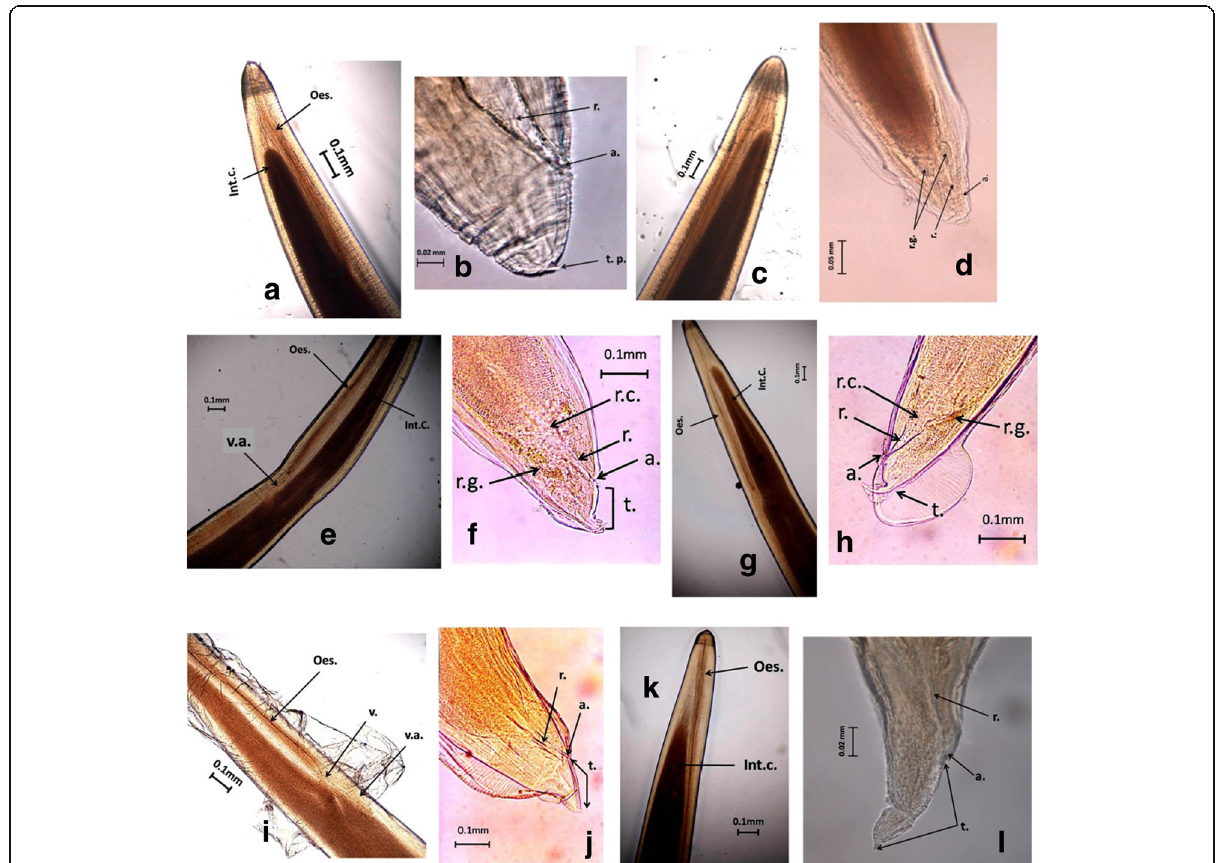
Fig. 1 Light microscopic study. a , b Anterior and posterior end of larva collected from Oreochromis niloticus ; c , d anterior and posterior end of larva collected from Tilapia galilae ; e , f anterior and posterior end of short form larva collected from Lates niloticus ; g , h anterior and posterior end of long form larva collected from Lates niloticus ; i , j anterior and posterior end of short form larva collected from Hydrocynus forskahlii ; and k , l anterior and posterior end of long form larva collected from Hydrocynus forskahlii . Magnifications: a , c , e , g , i and k (×4); b and l (×40); d (×20); f , h and j